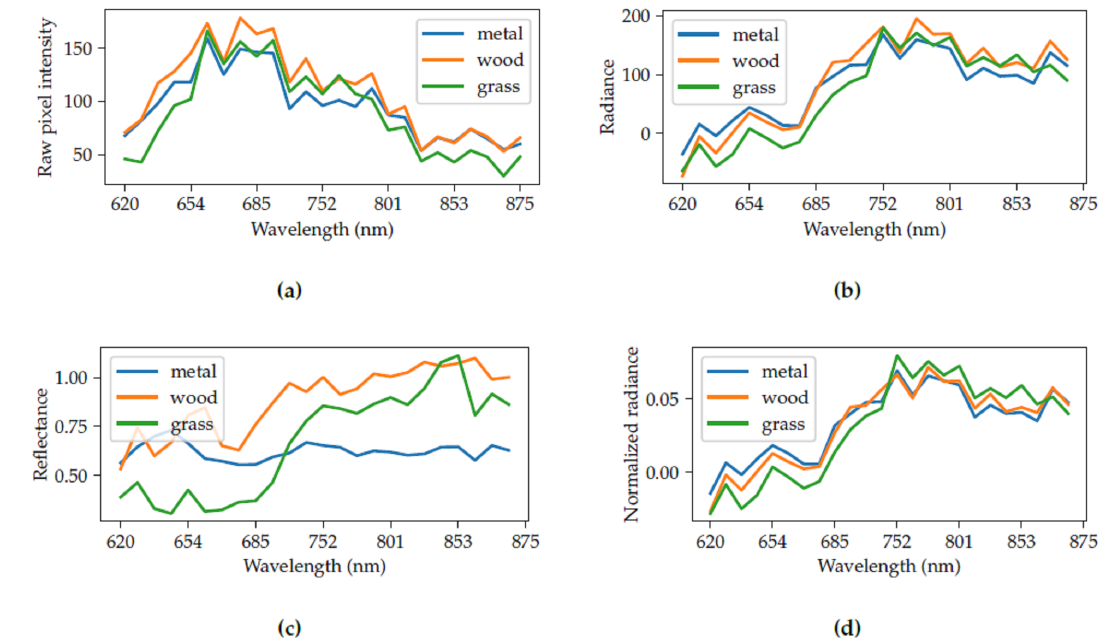
Figure 4. ( a ) Raw pixel intensity, ( b ) radiance, ( c ) reflectance, and ( d ) normalized radiance of different materials in a hyperspectral